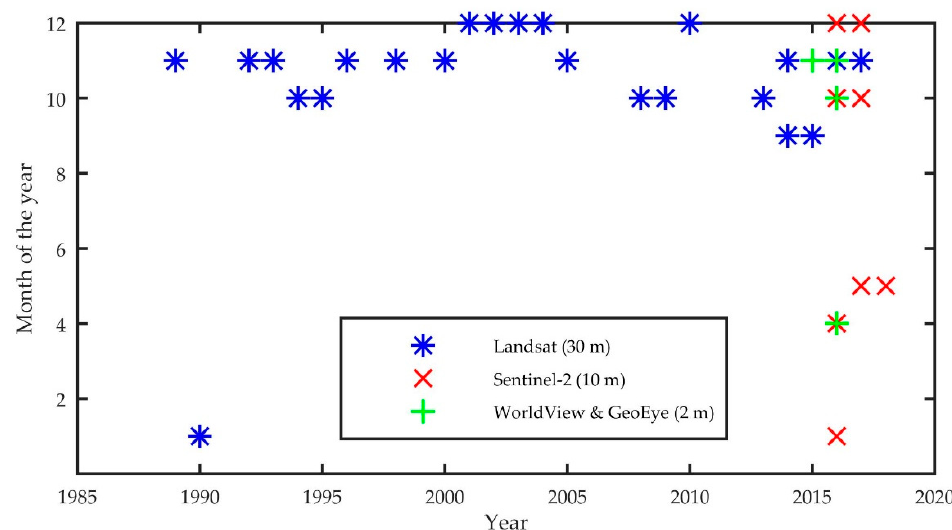
Figure 2. Temporal and seasonal distributions of scenes used in the study. Blue marks are for Landsat, red marks for Sentinel-2, and green marks for WorldView and GeoEye scenes.